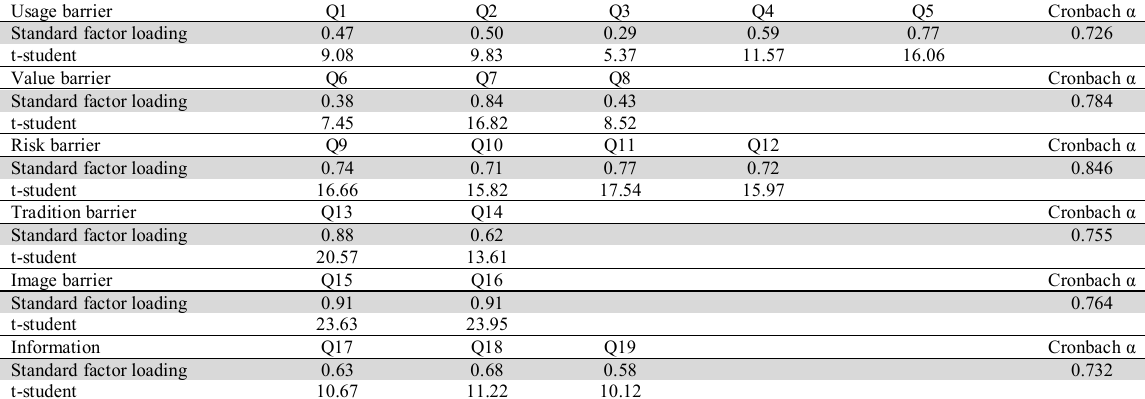
Factor loading result Usage barrier